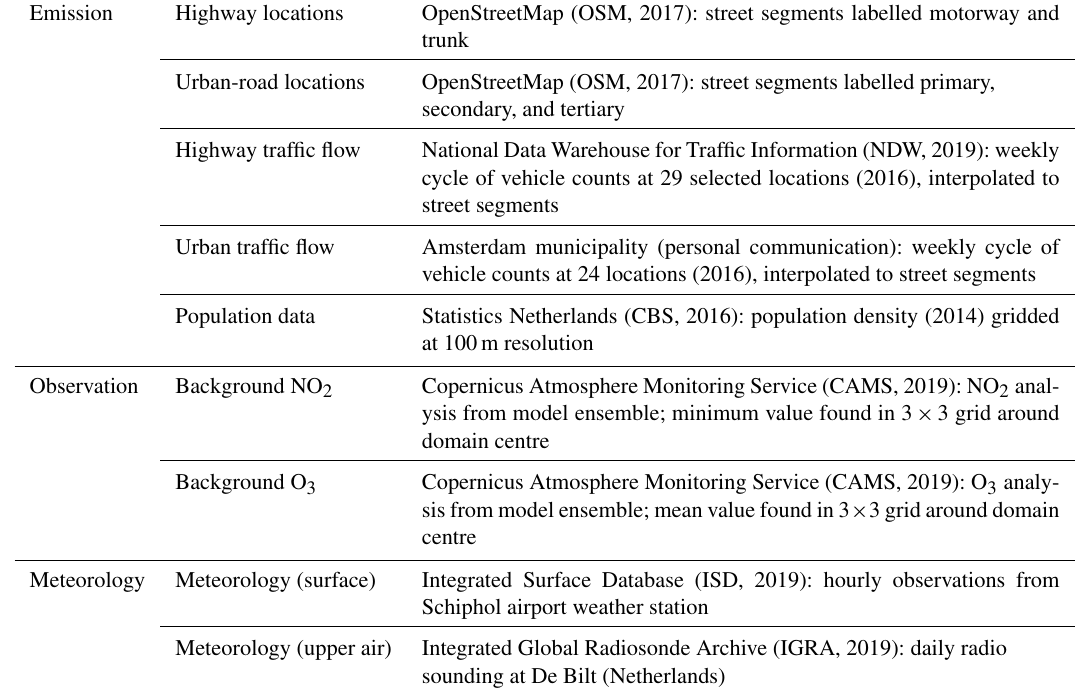
Table 2. Summary of simulation input data for